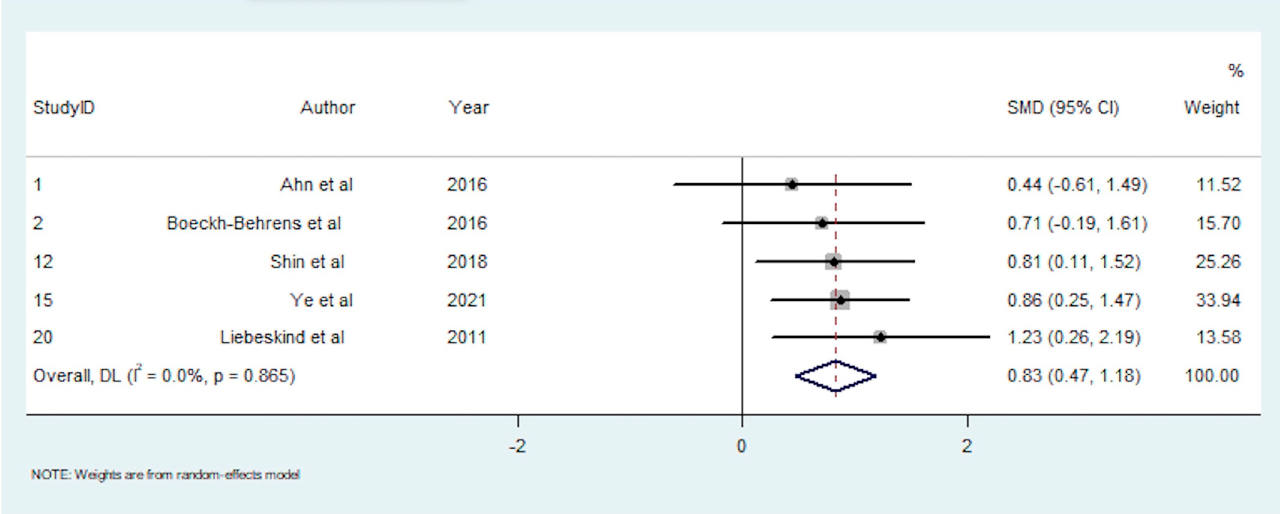
Figure 7. Forest Plot of Meta-analysis on RBC Content and Positive HMCAS. Abbreviations: DL: DerSimonian and Laird method, SMD: Standarized Mean Difference, CI: Confidence Interval, RBC: Red Blood Cell, HMCAS: Hyperdence Middle Cerebral Artery Sign.